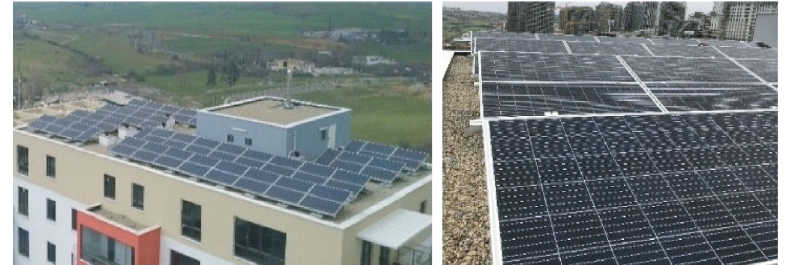
Figure 1: The roof type SPP and its PV